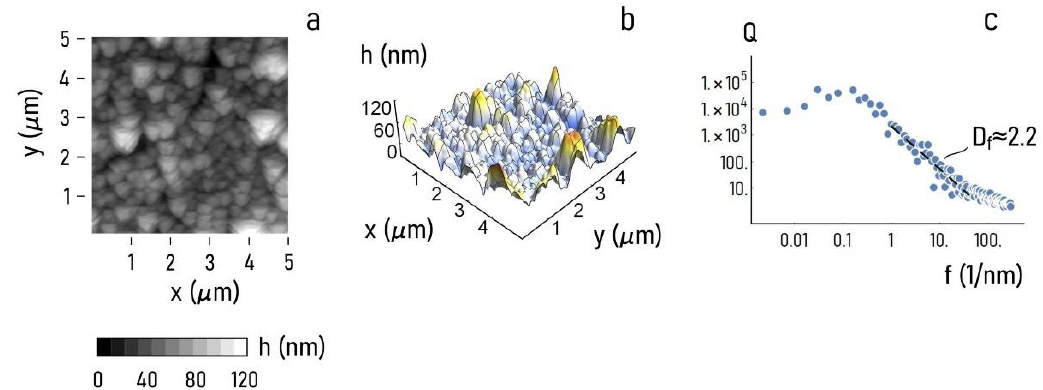
Figure 4. Atomic force microscopy (AFM) was used to image the gold nanoparticles with maximum resolution. Surface density plot ( a ) and 3D ( b ) plots of the AFM surface profile show that the maximum particle height in a 5 × 5 μm 2 scan area is about 120 nm 2 . Power spectrum density function extracted from the AFM scan reveals the hierarchical structure of the sample surface at the nanoscale ( c ).